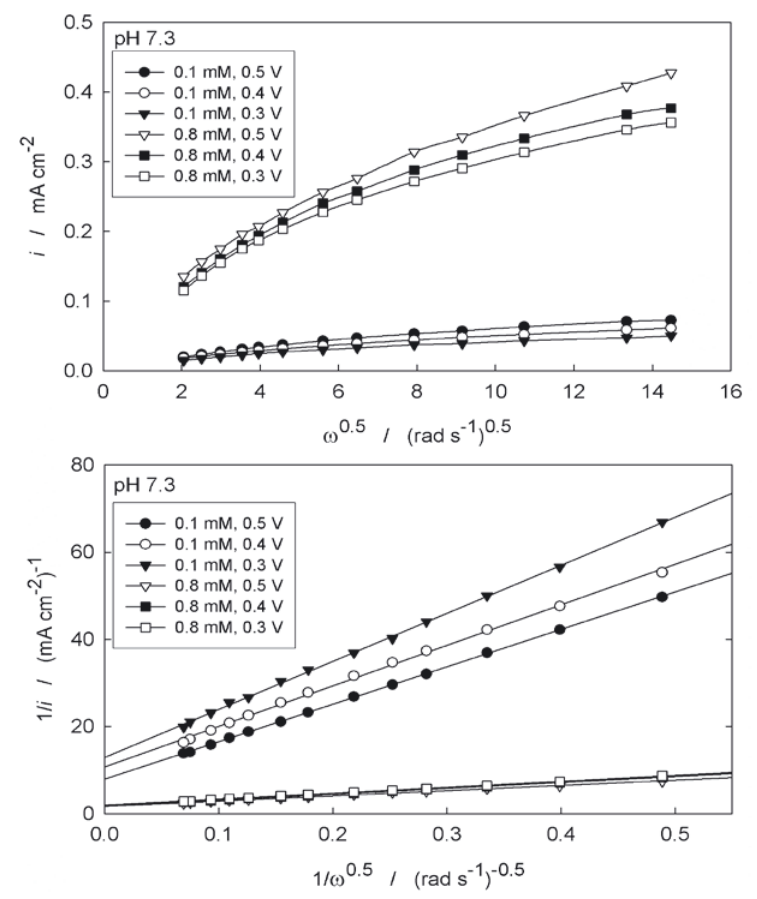
Figure 4. Same as in Fig. 3, obtained in pH 7.3